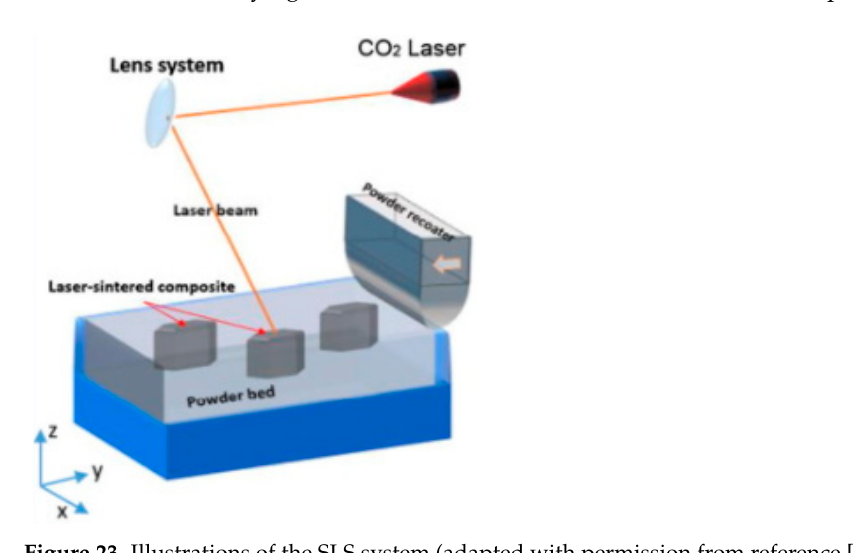
Figure 23. Illustrations of the SLS system (adapted with permission from reference [60]).